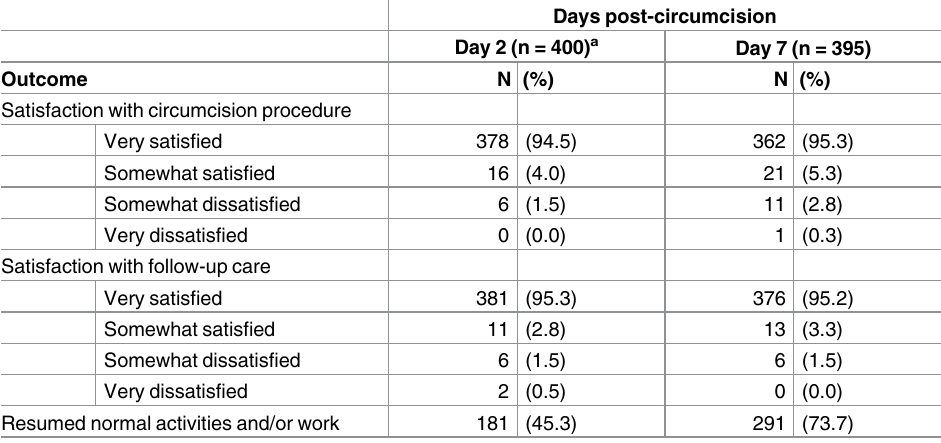
Table 2. Satisfaction with circumcision procedure and follow-up at 2 and 7 days post-circumcision among HIV-uninfected, sexually-active adult men circumcised within the National Safe Male Circumci- sion program in Gaborone,